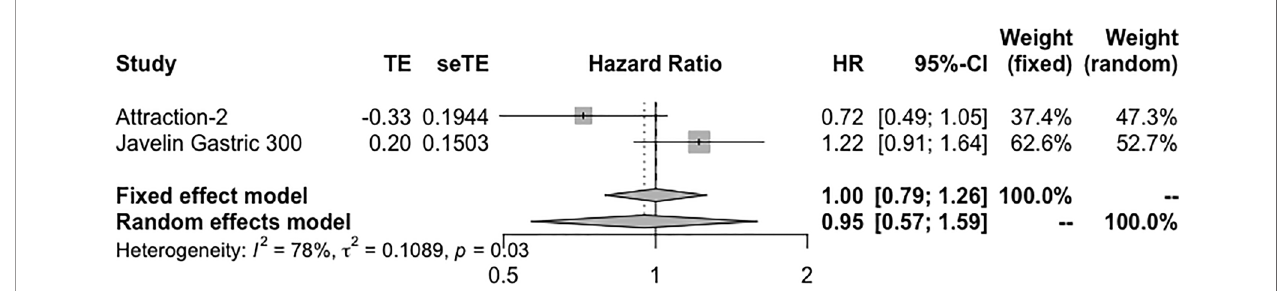
Figure S4 . ORR in patients receiving ICI monotherapy and